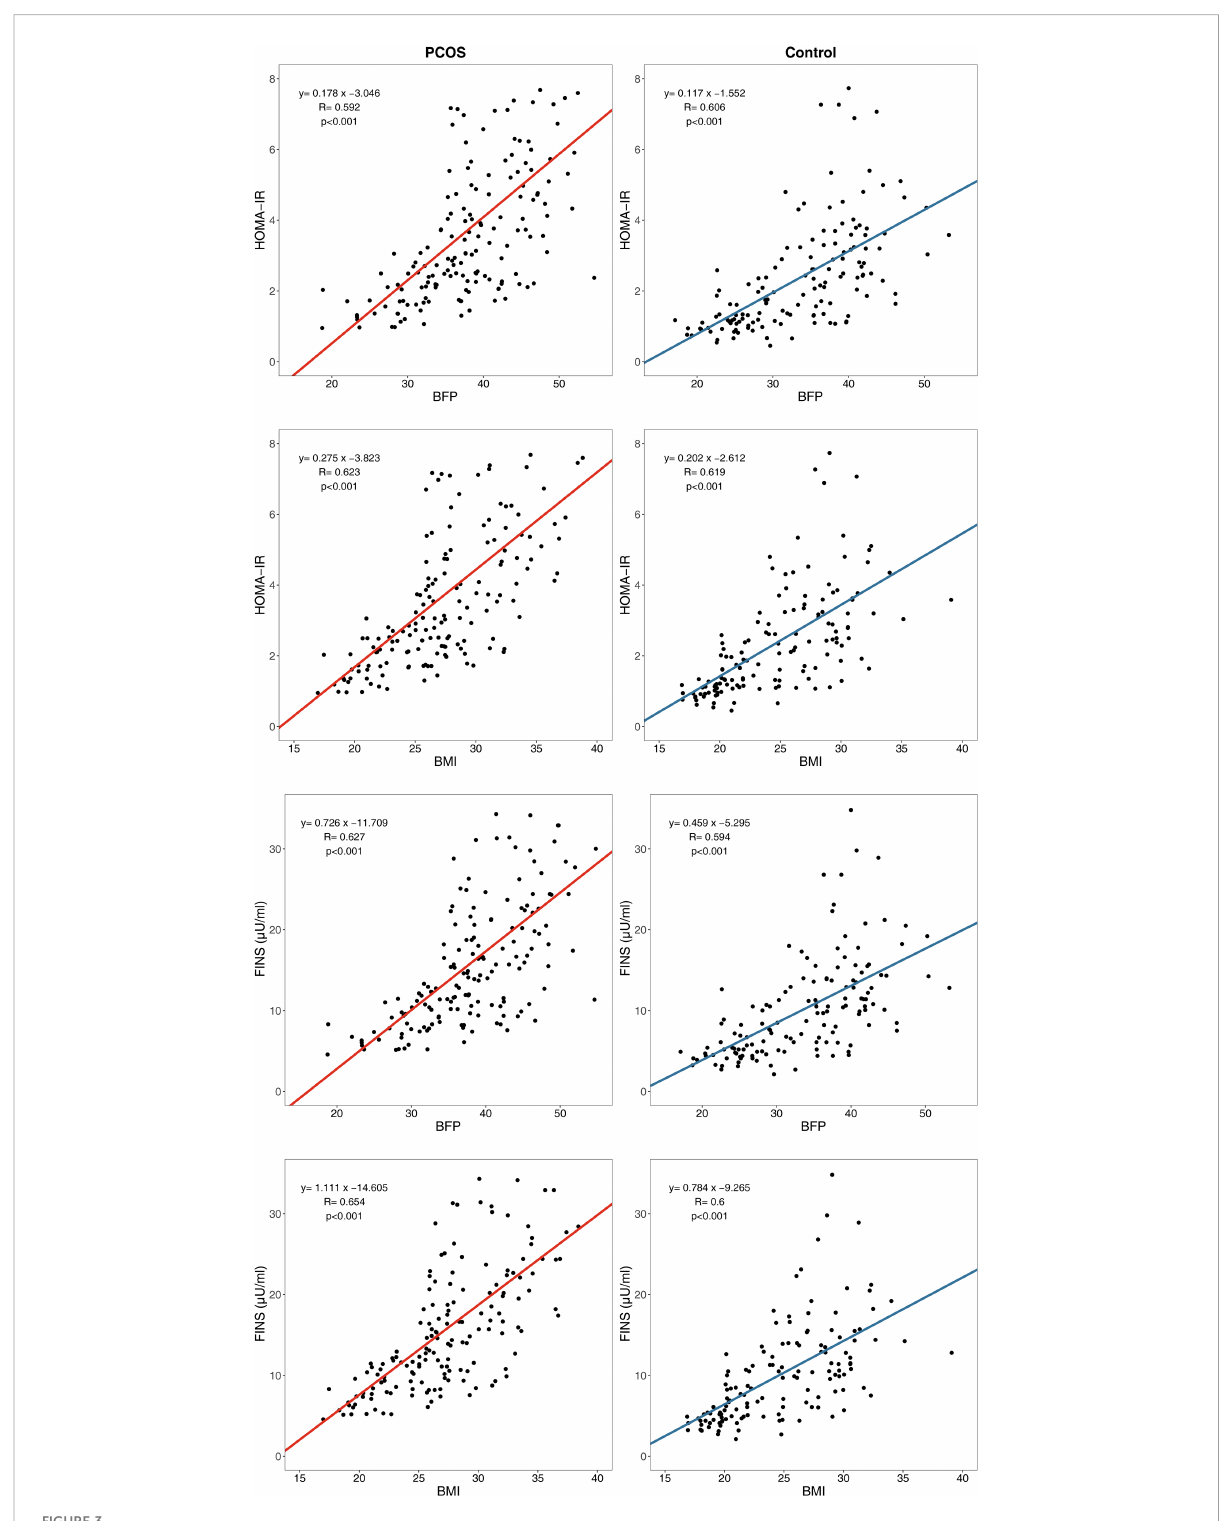
FIGURE 3 Linear regression between body composition index and glucose metabolism index. HOMA-IR, homeostasis model assessment of insulin resistance; FINS, fasting insulin; BFP, body fat percentage; BMI, body mass